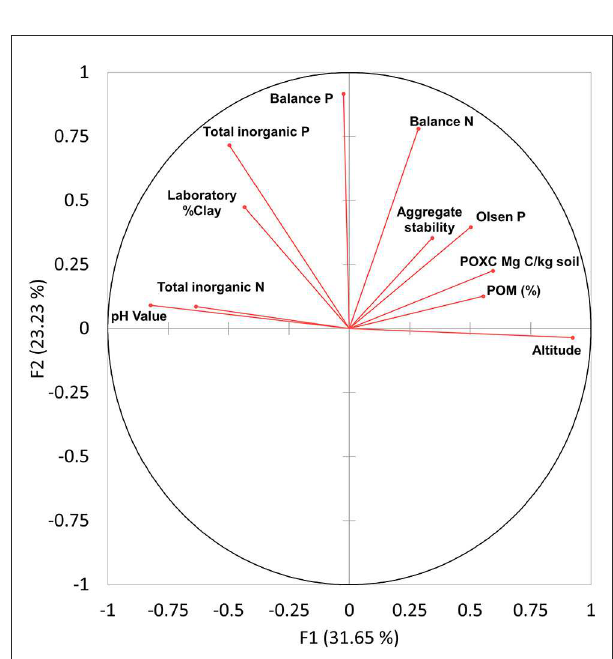
FIGURE5 Principal component analysis of the key site and soil variables drawn from 45 farm fields for bean cultivation in Narumu Ward, Kilimanjaro Region, Tanzania. Percent variability explained by each principal component (PC) is indicated along the